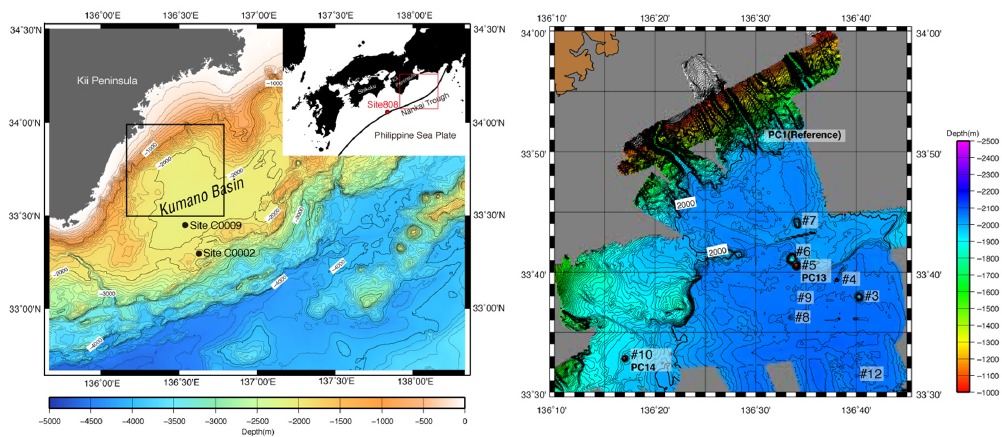
Figure 1. Location map of the Kumano basin showing core sites PC12 (reference site), PC13 (KMV#5), and PC14 (KMV#10), and IODP and ODP Sites. Numbers with # indicate the locations of KMV#3–10 and KMV#12.